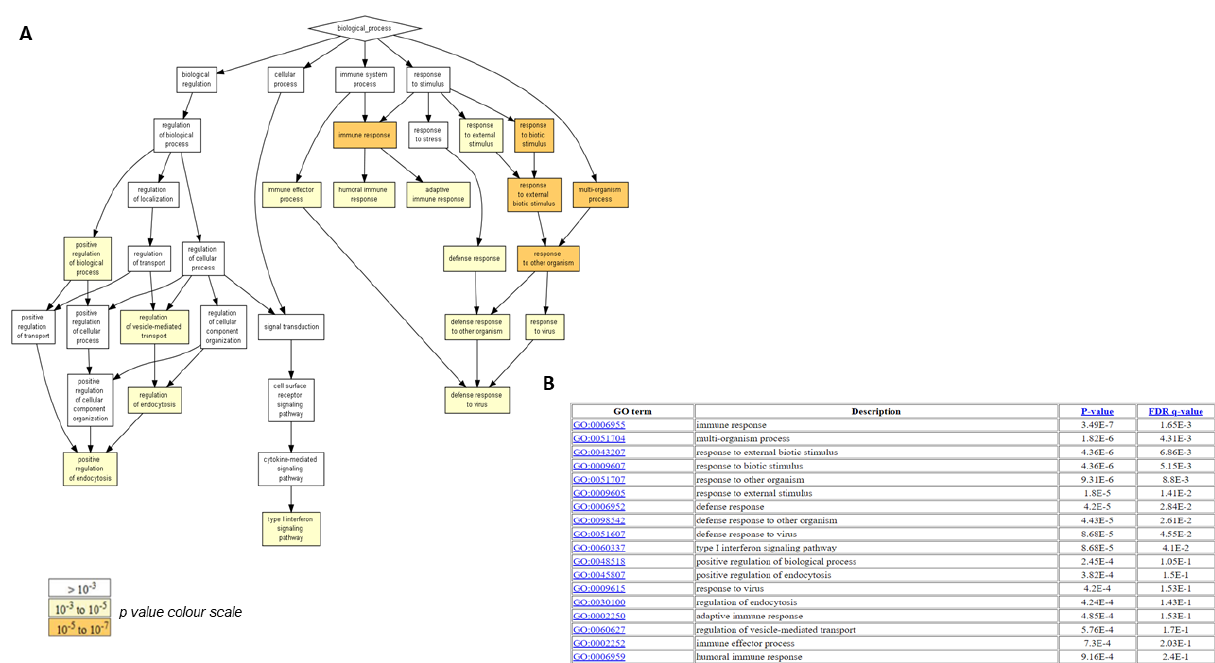
Figure 4. Gene ontology functional enrichment analysis of differentially expressed genes modulated by Crenigacestat. The deregulated genes after Crenigacestat treatment in HuCCT1-xenograft mouse model showed few enriched biological processes linked mainly to the immune response, response to external stimuli, and regulation of vesicle-mediated transport. Enriched GO terms are visualized using ( A ) a directed acyclic graph (DAG) graphic representation with color coding reflecting their degree of enrichment and ( B ) a table with the corresponding p -value and FDR q-value for each term.